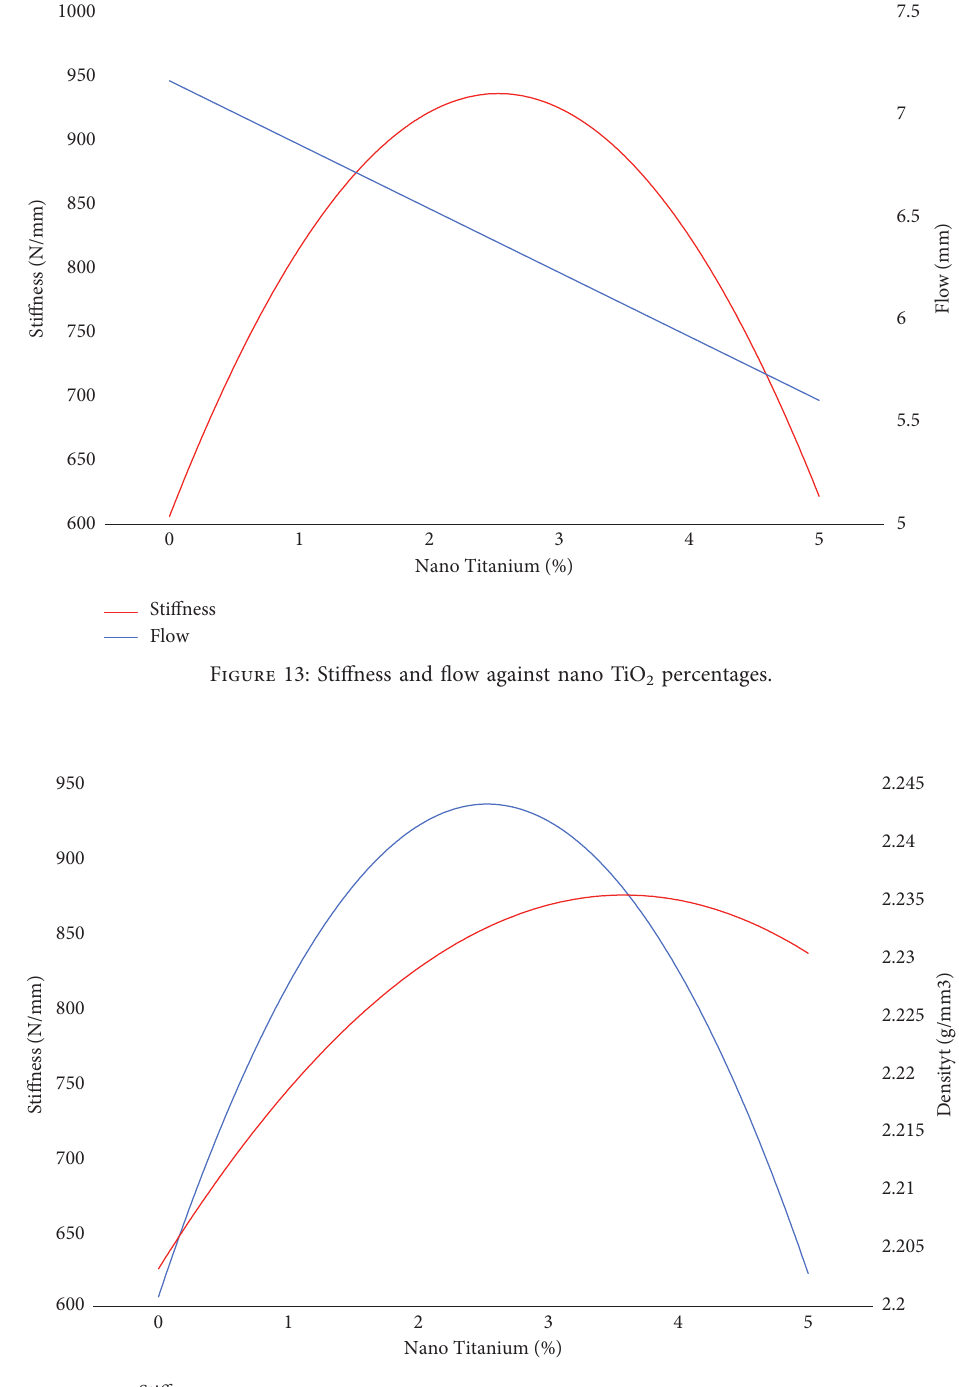
Figure 14: Stiffness and density against nano TiO